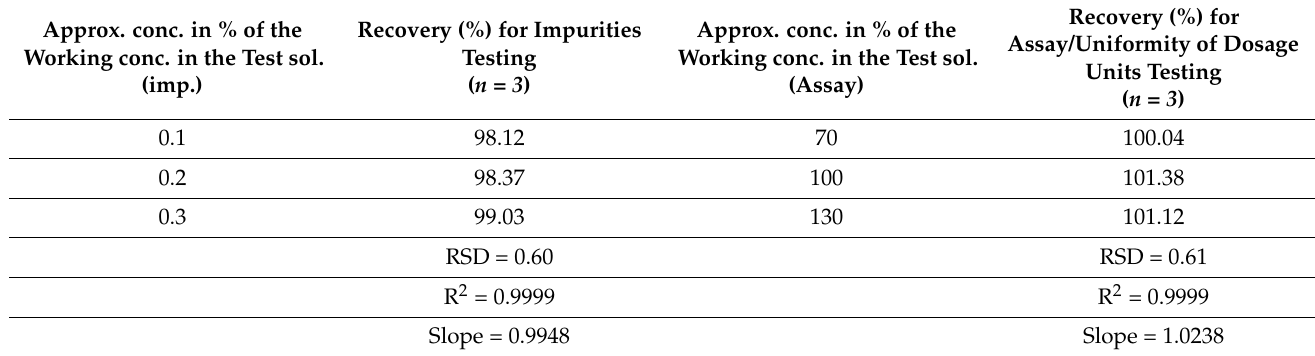
Table 3. Results of the accuracy of the method for the analysis of atorvastatin and its impurities. Approx. conc. in % of the Working conc. in the Test sol.